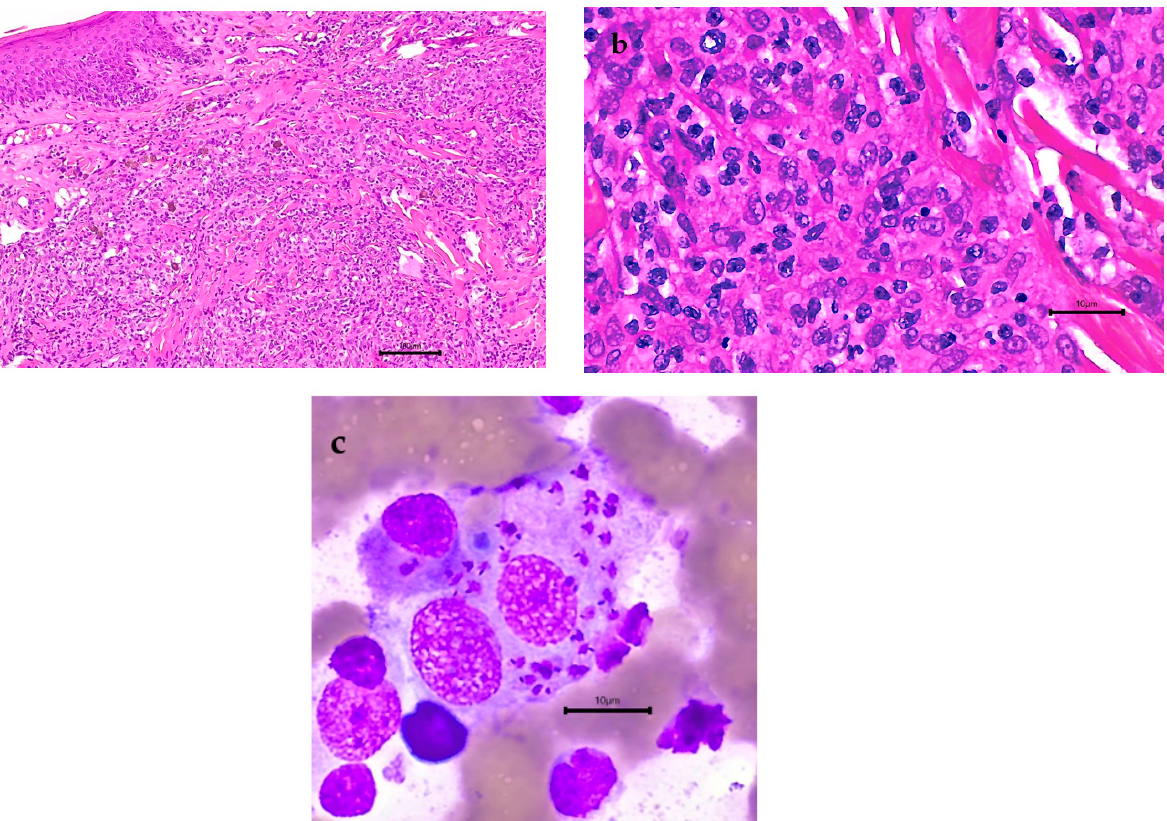
Figure 3. Nasal mucosa histology and splenic aspirates from dog 2: ( a ) Histopathology of nasal mucosa with granulomatous inflammation. Haematoxylin and eosin staining; bar = 100 um. ( b ) Nasal sub-mucosa with macrophages admixed with fewer neutrophils, plasma cells, and small lymphocytes. Haematoxylin and eosin staining; bar = 10 um. ( c ) Splenic aspirate. Wright’s Giemsa stain. Leishmania amastigotes within the cytoplasm of macrophages. Bar = 10 um.